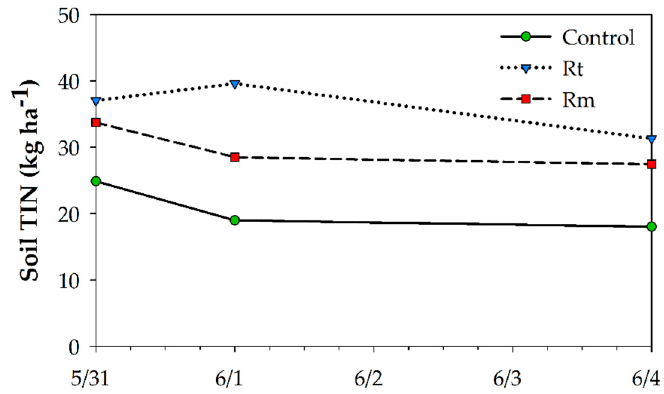
Figure A2. Soil TIN concentration as a function of management system following residue management, where clover was returned (Rt) or removed (Rm) from the plot and preceding row establishment and with unmanaged clover (Control).